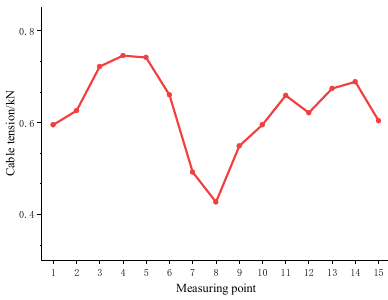
Figure 22. Cable tension variation curve. (2) Radar data processing Table 1. Cable end tension values of different measuring points. Along the Long Side Along the Short Side Measuring Point Cable Tension(kN) Measuring Point Cable Tension(kN)